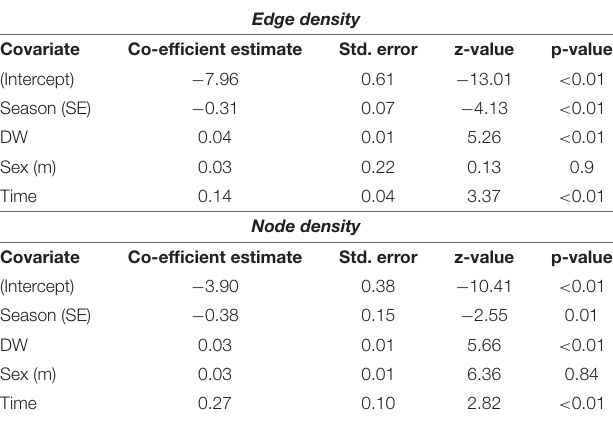
TABLE 2 | Outputs of the Generalized Linear Mixed Models testing whether season, time, and individual disc-width (DW) and sex influenced metrics from network analysis (edge and node densities of networks) performed on acoustic detections for P. ater